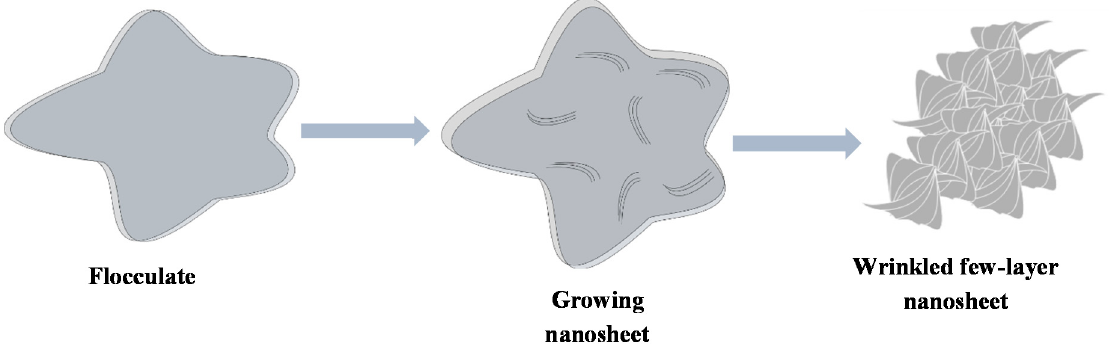
Figure 4. The TEM images of the MoSe 2 nanosheets: ( a – c ) are images of the nanomaterial taken at 30 min, ( d – f ) are the TEM images for MoSe 2 wrinkled few-layer nanosheets at 60, 90 and 120 min.